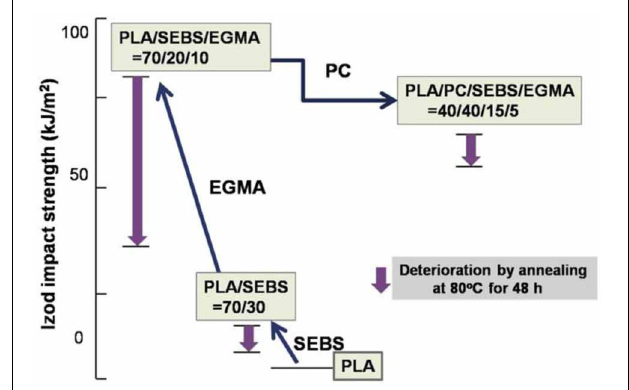
FIGURE 24 | Izod impact strength as a function of PLA-based material formulation [Reprinted from Hashima et al. (2010) with permission from Elseiver].